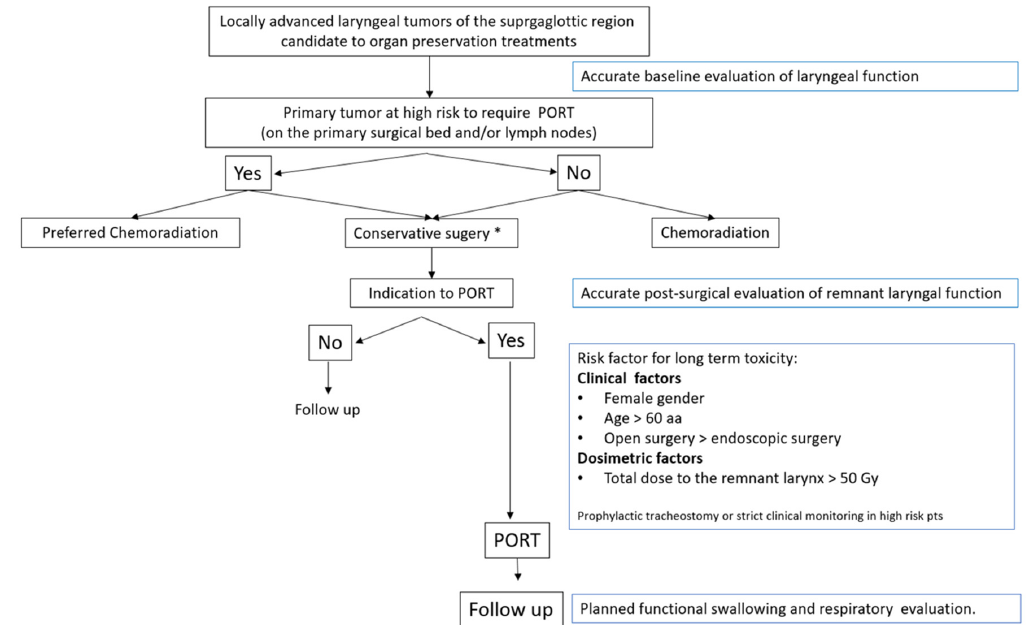
Figure 1. Workflow for patients with locally advanced laryngeal cancers involving the supraglottic region who are candidates for an organ ‐ preservation approach. *High ‐ volume centers with expert surgeons and availability of multidisciplinary rehabilitation service.